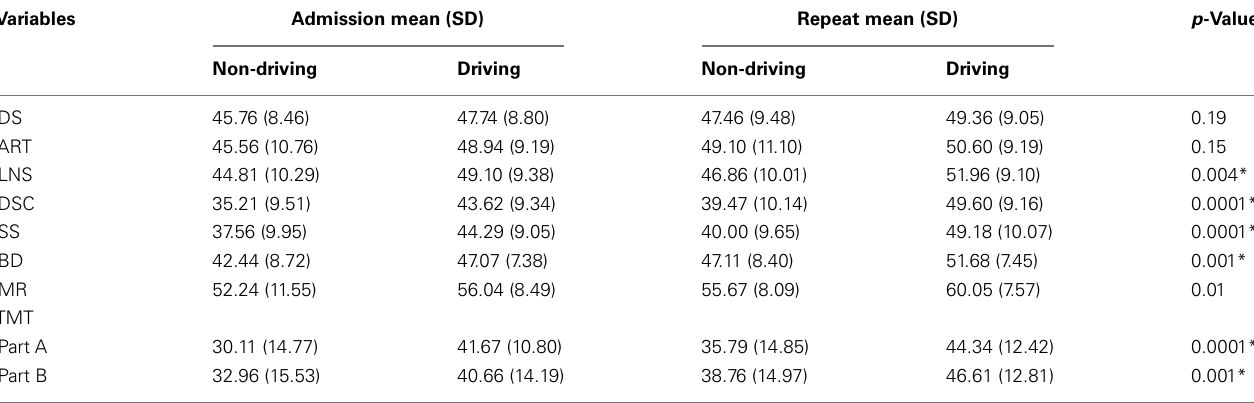
Table 4 | Differences in cognitive outcome between driving and non-driving groups using repeated measuresANOVA.